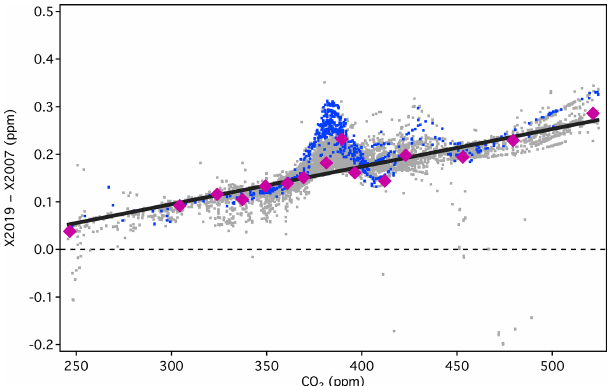
Figure 13. Differences between X2019 and X2007 tertiary assign- ments from 1995 to 2017 (NDIR only), showing 2008 analysis in blue and all others in gray. A linear scale conversion derived from primary standards (pink) is shown as the black